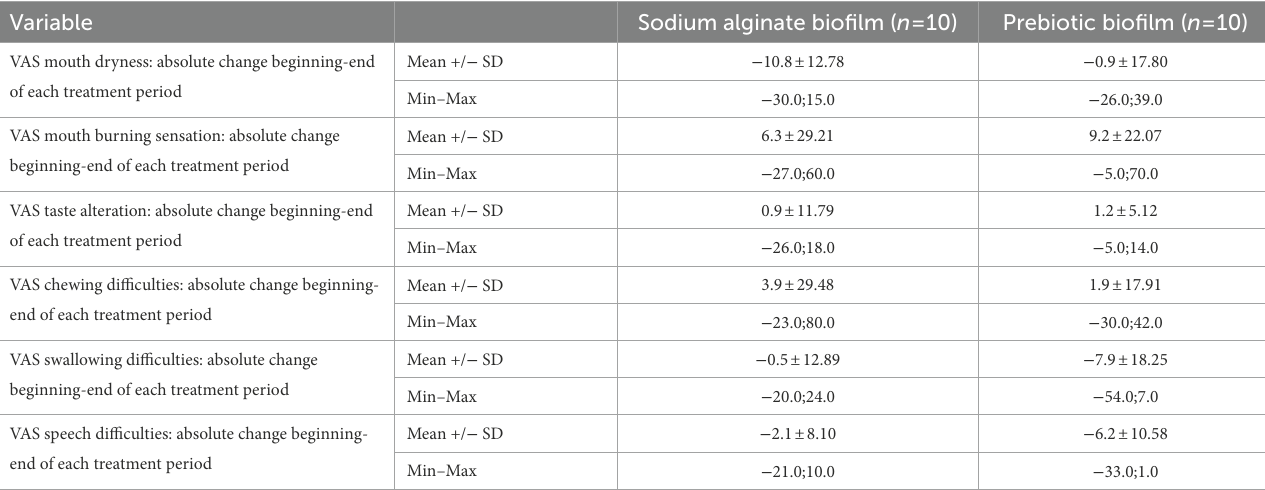
TABLE 4 Absolute change of start-end VAS of each treatment